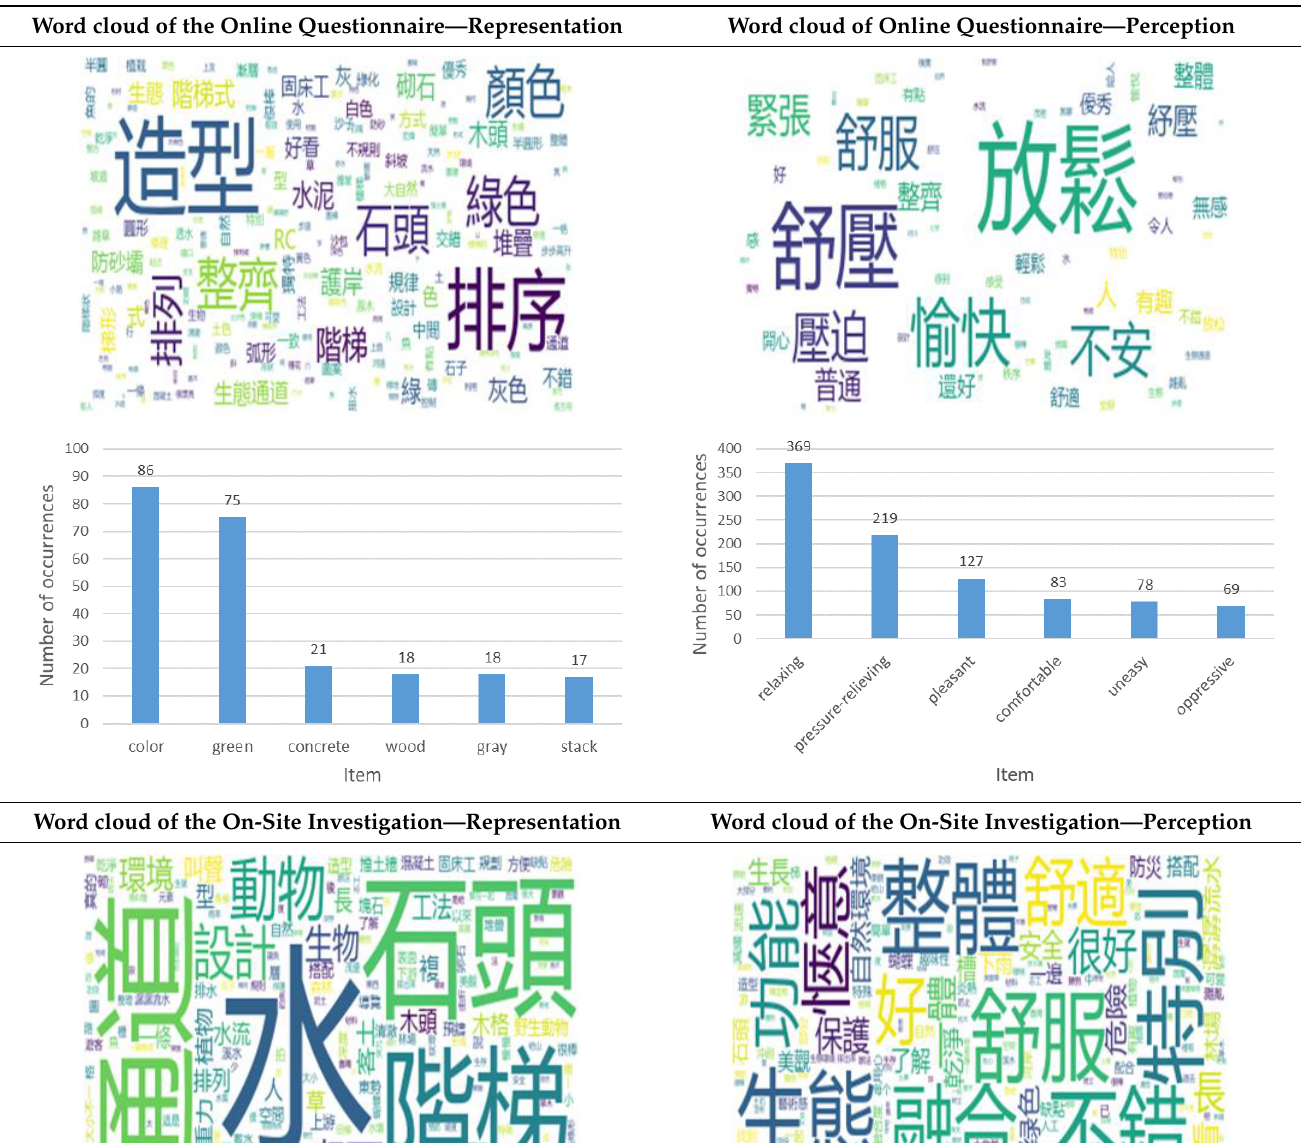
Table 6. Word cloud analysis of the “Renovation Project of Sijiaolin Stream”.